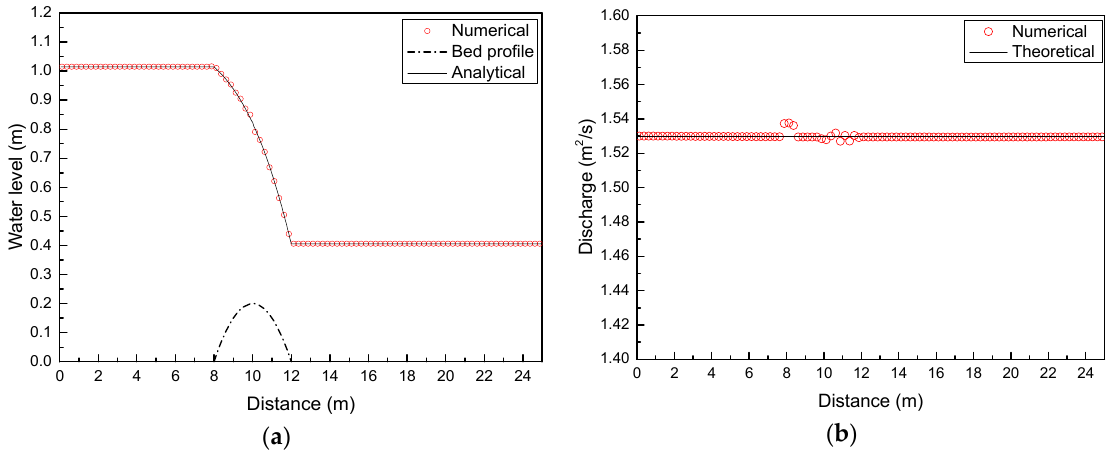
Figure 6. Transcritical flow without a shock over a bump: ( a ) comparison of the water level between numerical results and the analytical solution; ( b ) comparison of discharge.